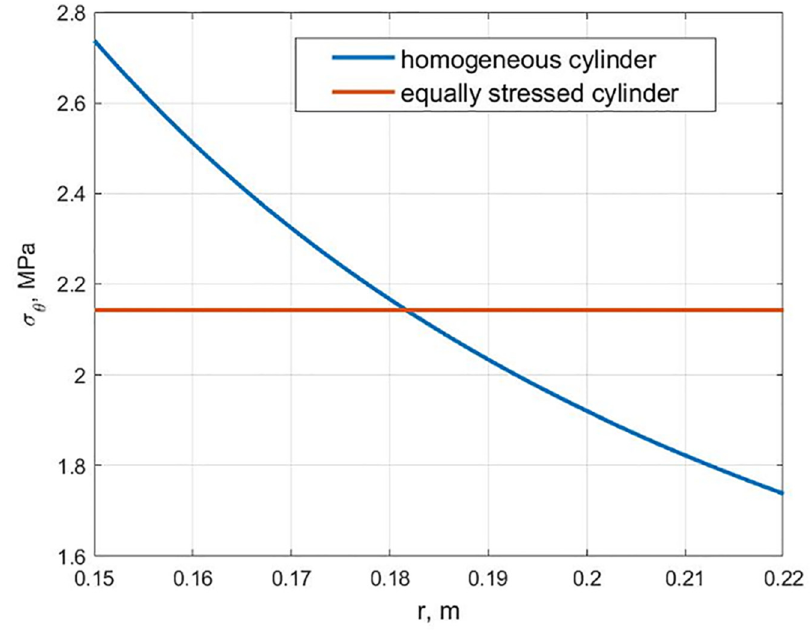
Figure 4. Distribution of stresses σ θ along the radius for a homogeneous and equally stressed cylin- der.